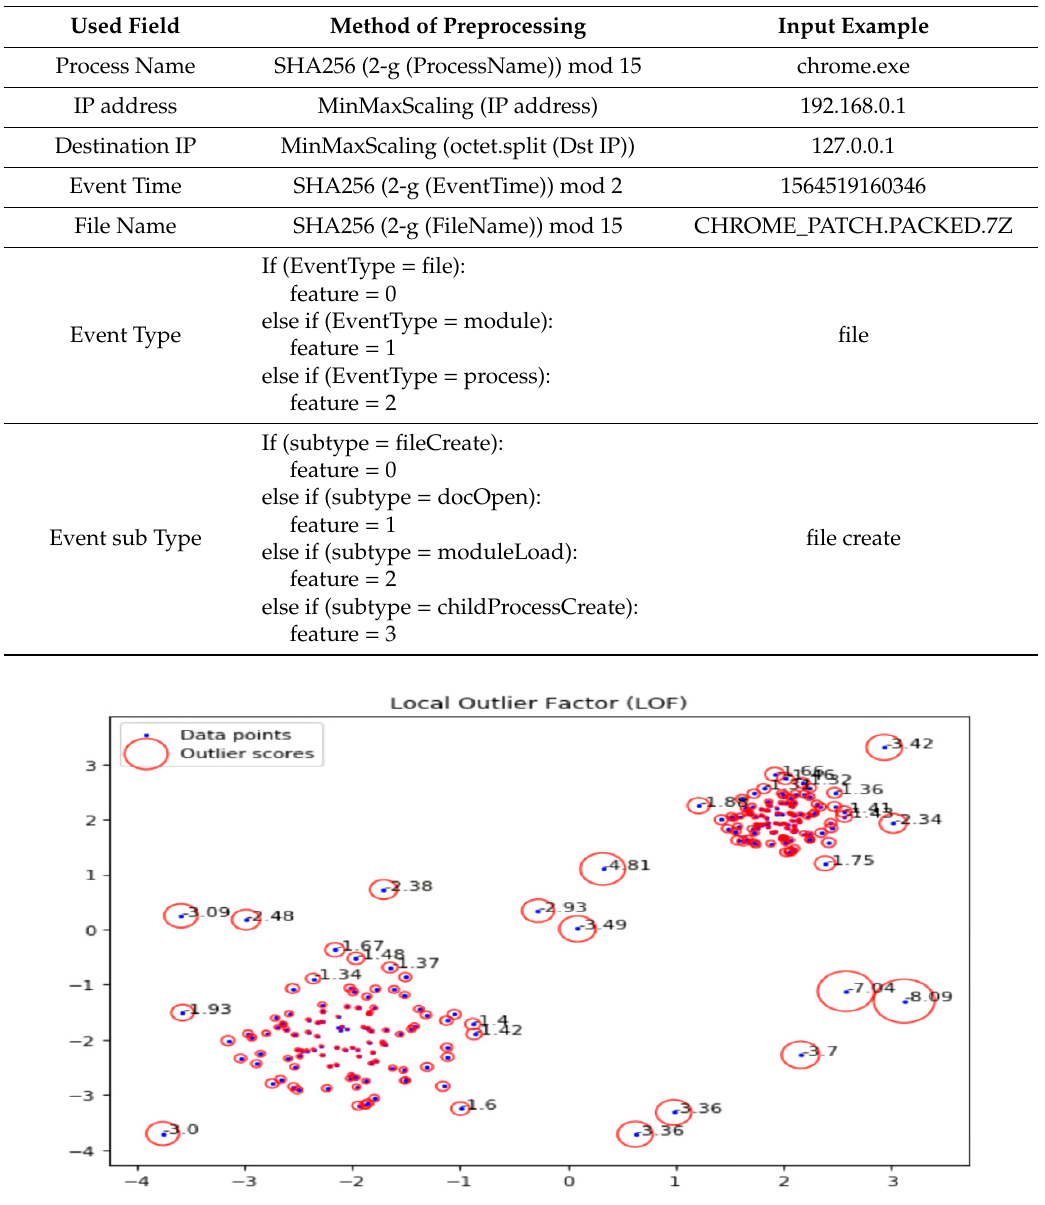
Table 3. Feature preprocessing of Endpoint log.